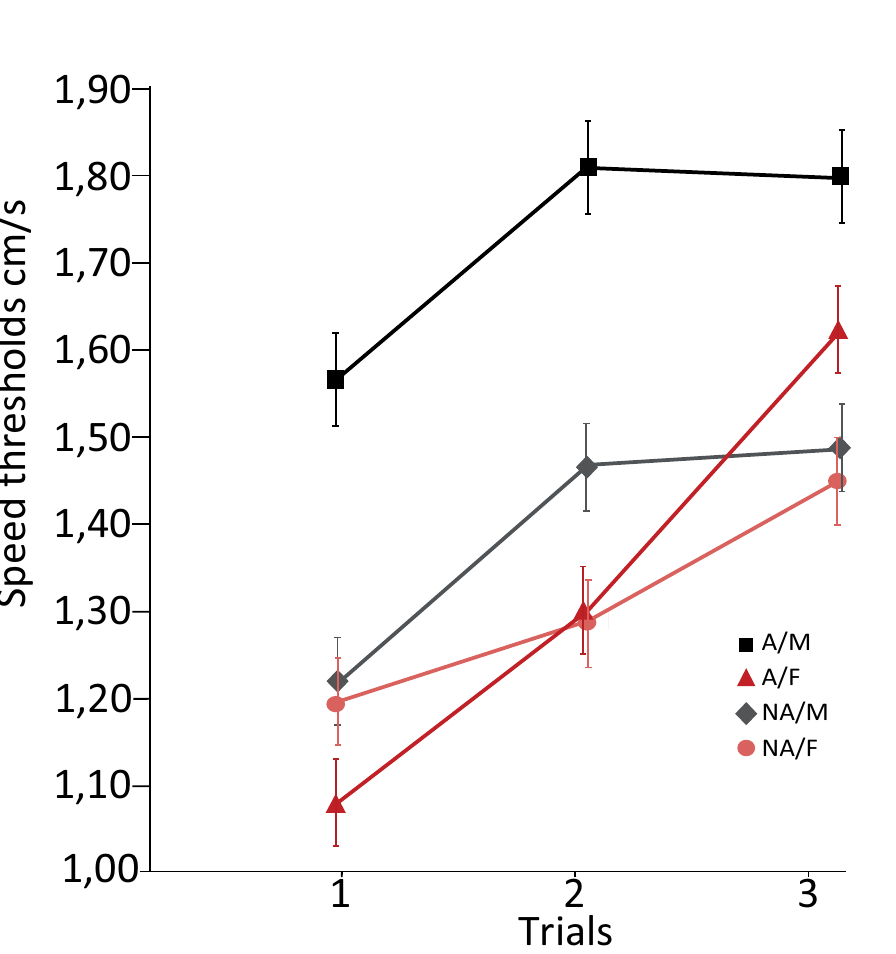
Fig 2. Athletes and non-athletes speed thresholds for 3 trials.